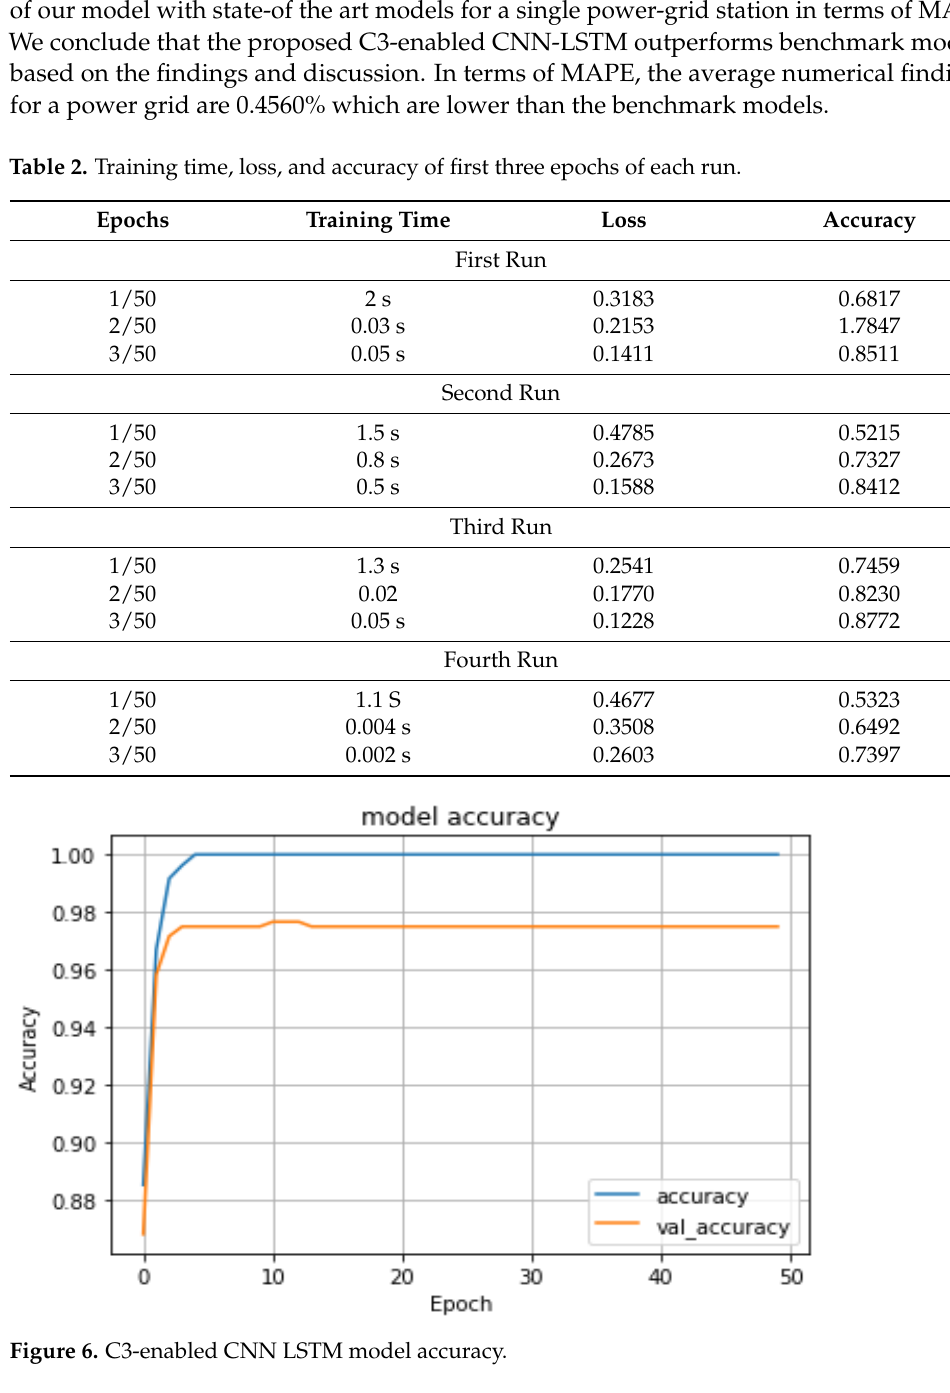
Figure 6. C3-enabled CNN LSTM model accuracy.